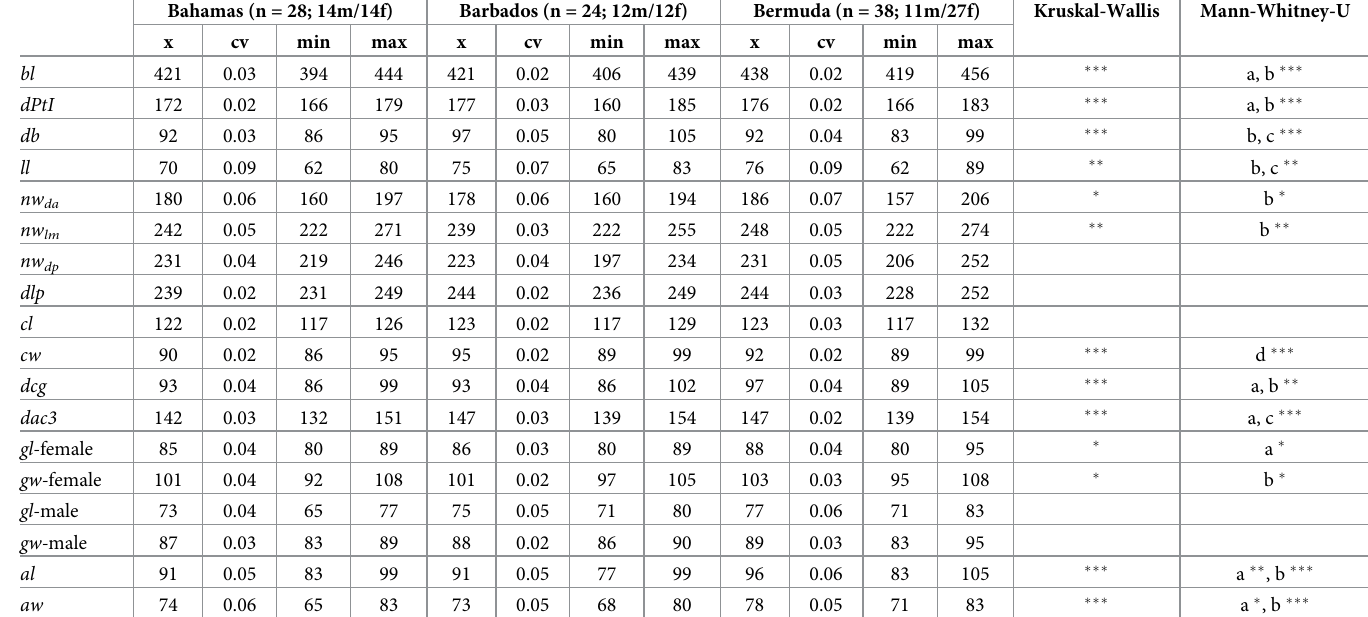
Table 1. Mean (x), standard deviation (sd), coefficient of variation (cv), minimum (min) and maximum (max) of three populations of Fortuynia atlantica . Results of Kruskal-Wallis and Mann–Whitney-U test are given; � p < 0.05, �� p < 0.01, ��� p < 0.001. a Bermuda vs Bahamas, b Bermuda vs Barbados, c Bahamas vs Barbados, d all possible combinations. Bahamas (n = 28;